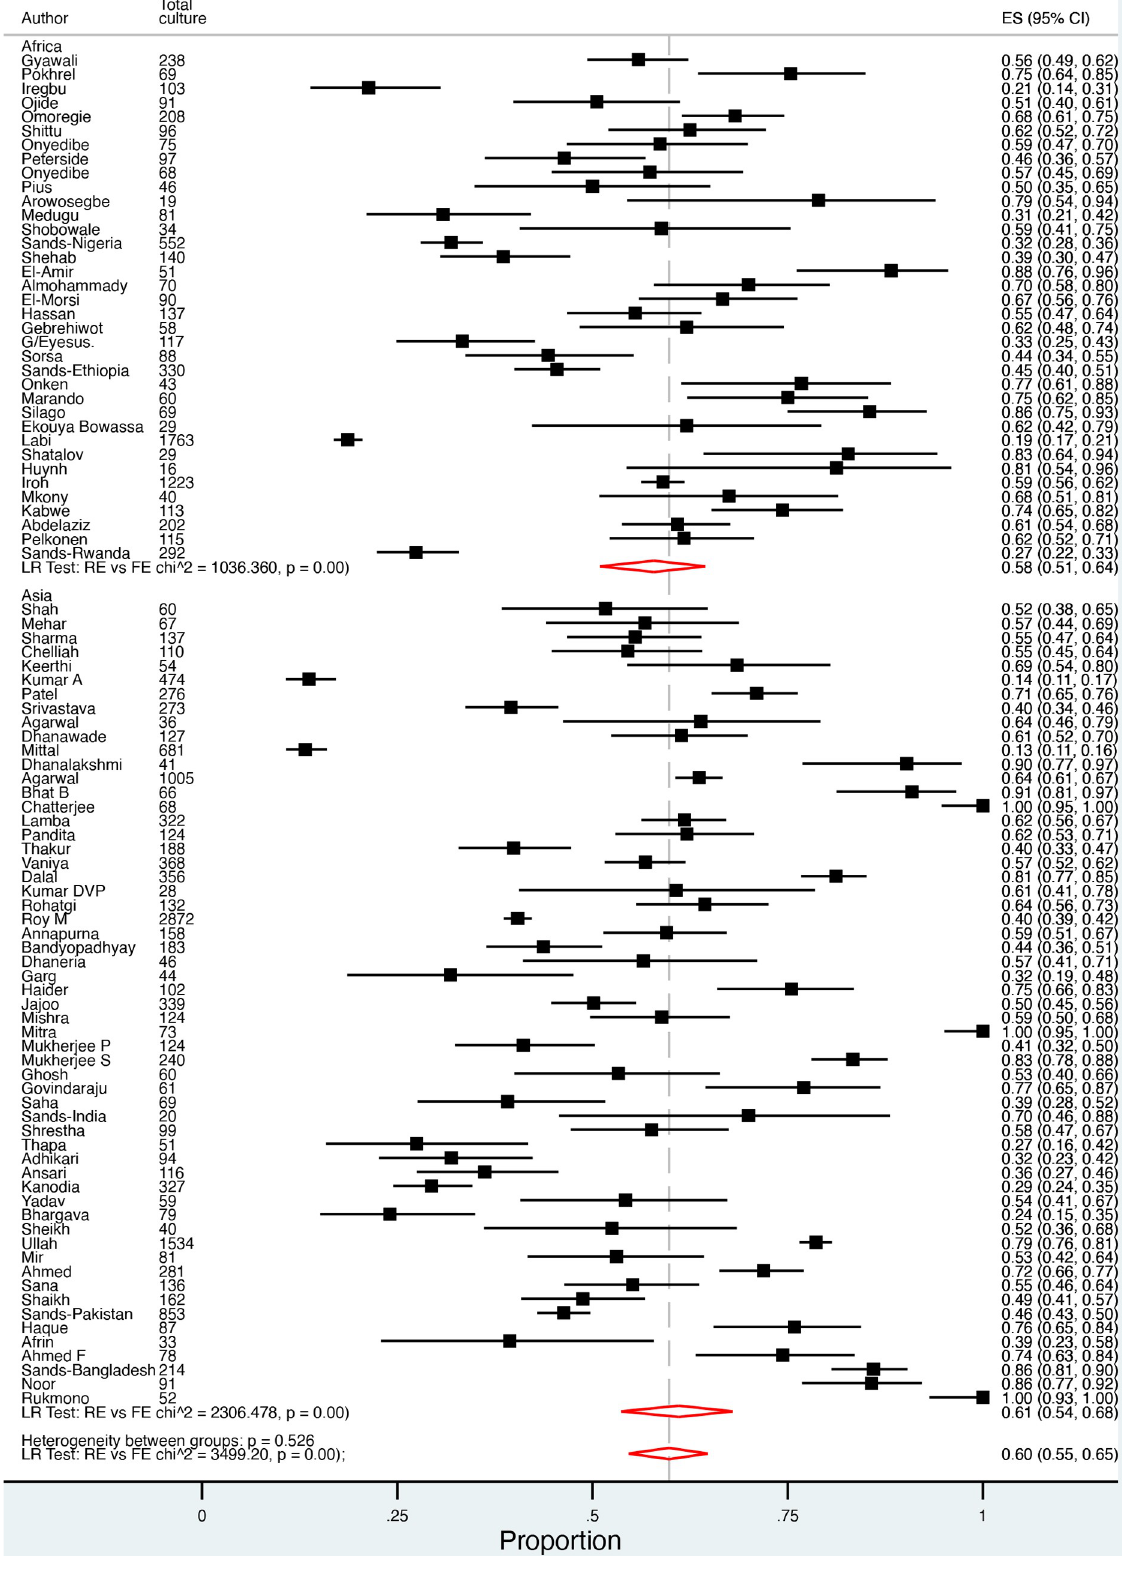
Fig 3. Pooled prevalence of Gram-negative neonatal sepsis. AU : InFig 3 legend : Pleasecheckthattheaddedabbreviationdefinitionsarecorrect : ES, effect size; FE, fixed effect; LR, likelihood ratio; RE, random effect. https://doi.org/10.1371/journal.pmed.1003787.g003 PLOS Medicine| https://doi.org/10.1371/journal.pmed.1003787 September 28,